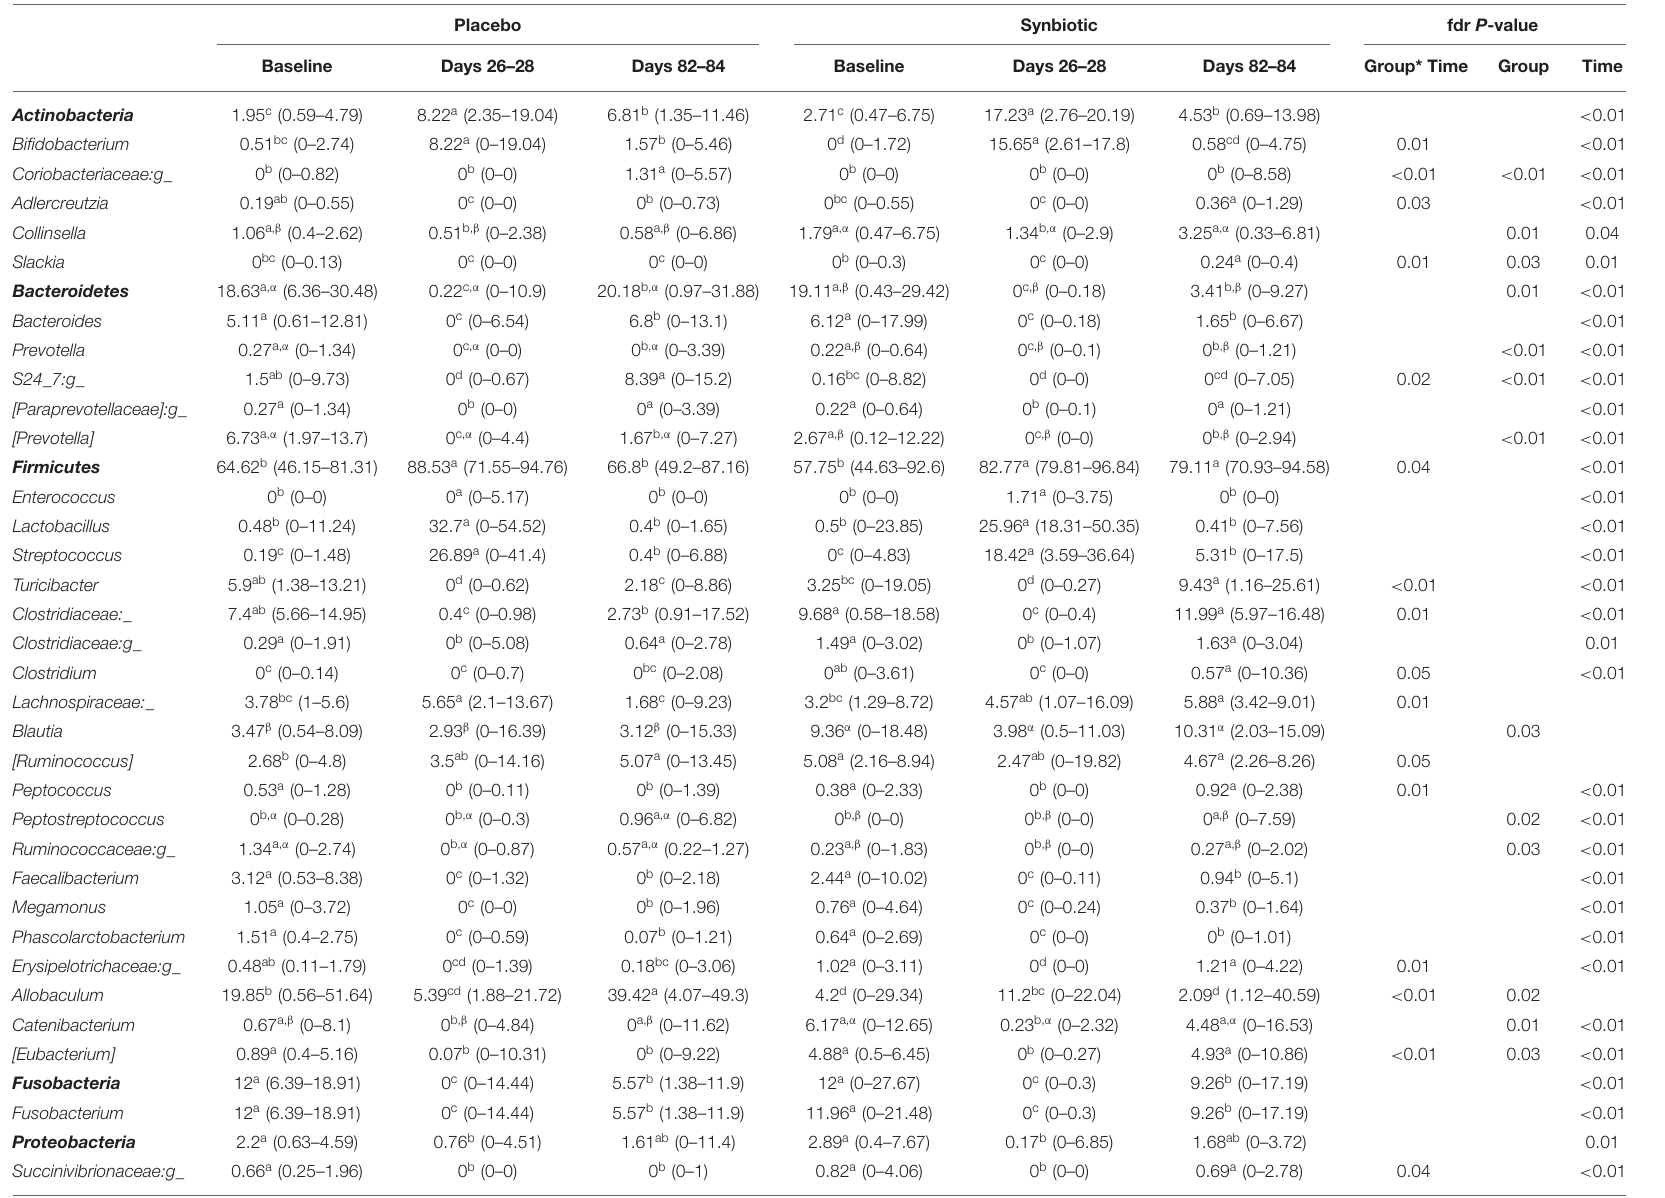
TABLE 2 | Median (range) percent relative abundances of bacterial phyla and genera for dogs that received enrofloxacin/metronidazole followed by placebo or synbiotic for 21